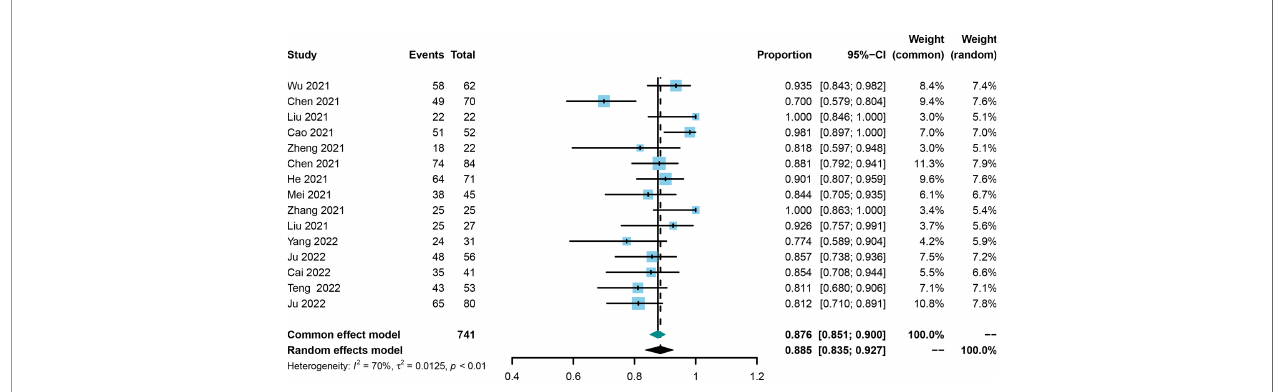
FIGURE 4 | Forest plot of the pooled disease control